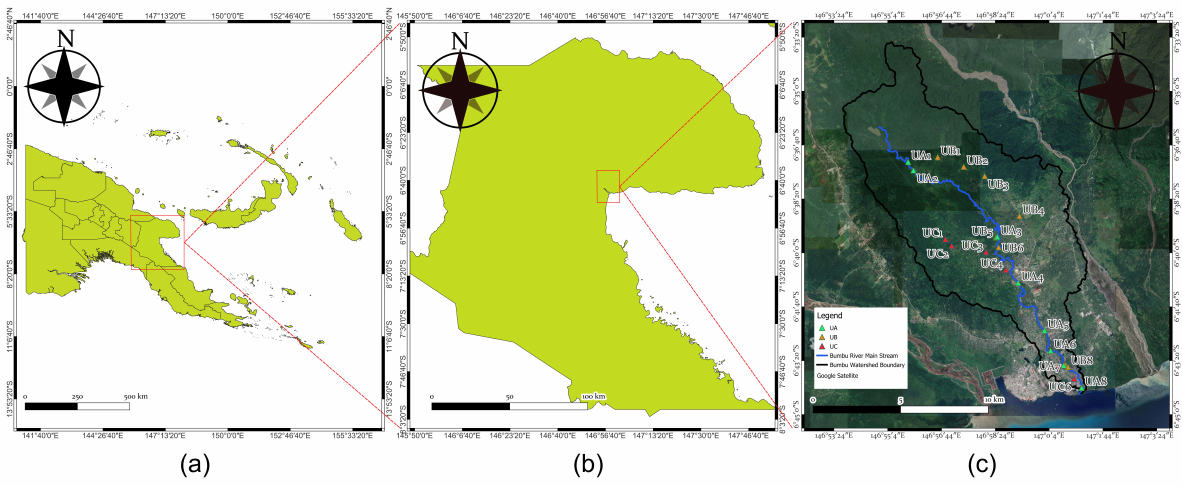
Figure 1. Map showing ( a ) Papua New Guinea, ( b ) Morobe Province and ( c ) Bumbu river